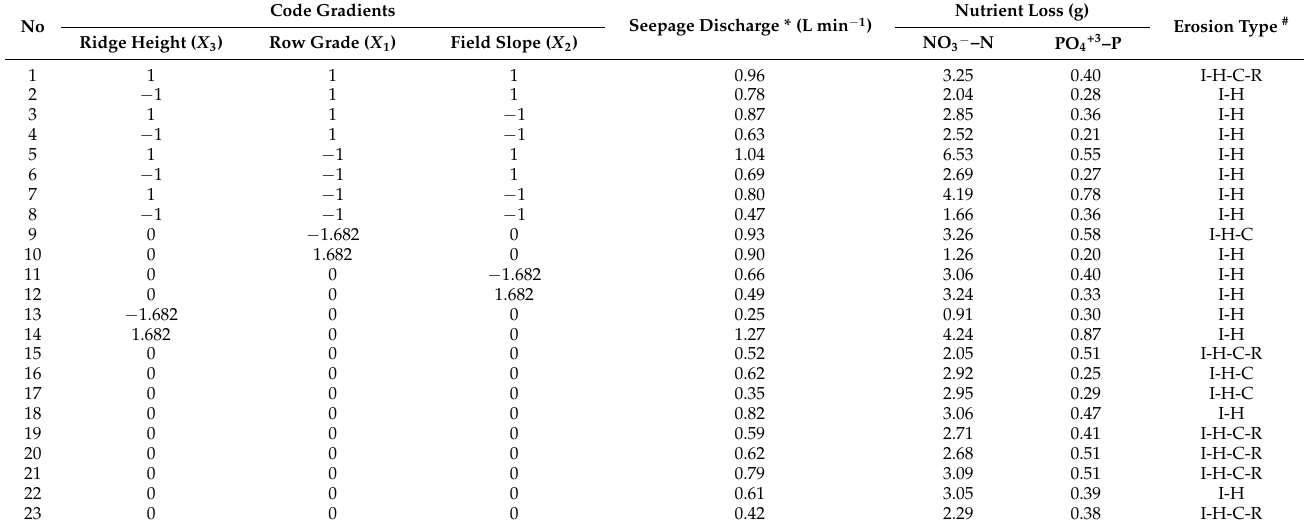
Table 2. The orthogonal rotatable central composite design for ridge height, row grade, field slope, and measured values for seepage discharge and NO 3 − –N and PO 4+3 –P losses under various erosion